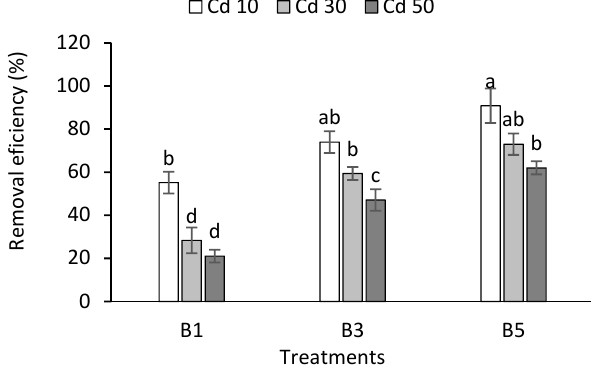
Figure 6. Effect of different levels of biochar on the removal efficiency in oak seedlings at different levels of Cd contamination (means + / - one standard error). Different letters represent significant differences between treatments.